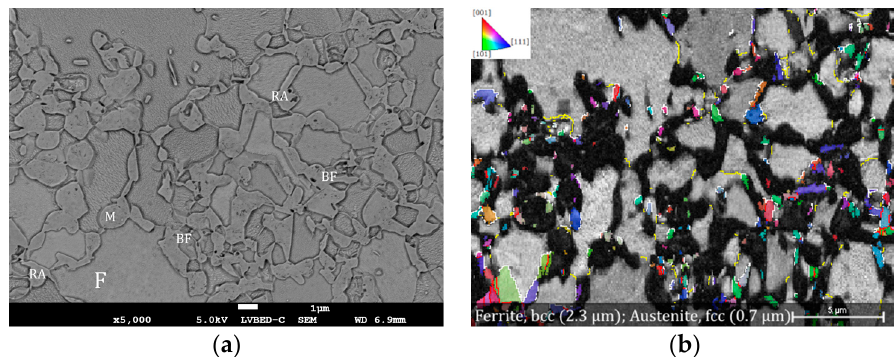
Figure 6. ( a ) Back-scatter electron detector micrograph Steel C IBT 480 ( a ) with annotations of phases: F = ferrite, BF = bainitic–ferrite, M = martensite, and RA = retained austenite. ( b ) EBSD PQM phase map of austenite (fcc) in IPF X colouring and grain size measurements of the same location of Steel C IBT 480 microstructure.